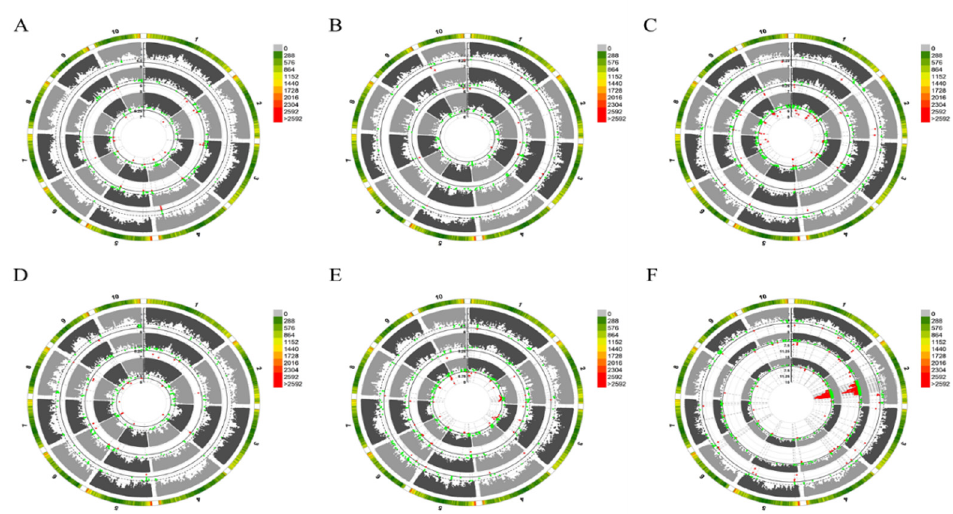
Figure 3. Manhattan plots on ten maize chromosomes for six traits in three locations. ( A ) Fe; ( B ) Zn; ( C ) Cu; ( D ) Mn; ( E ) As; ( F ) Cd. The circle from inside to outside represents HN, DY, XX and marker density. The red dotted line and black line indicate the significance at p = 10 − 4 and p = 10 − 5 level, respectively. The outermost circle shows the SNPs density on the 10 chromosomes. The marker density was shown in the color legend on the right side of the figure. Table 3. Functions of the SNPs located genes associated with at least two trace elements.